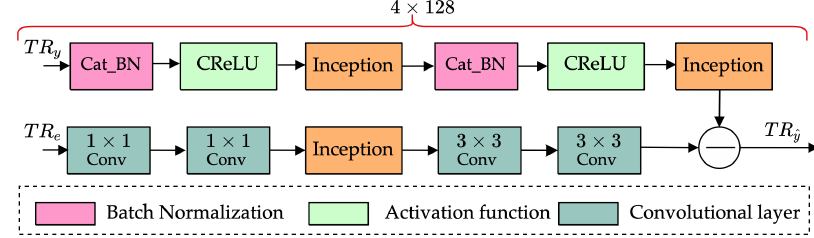
Figure 11. Structural composition of the RCL module.